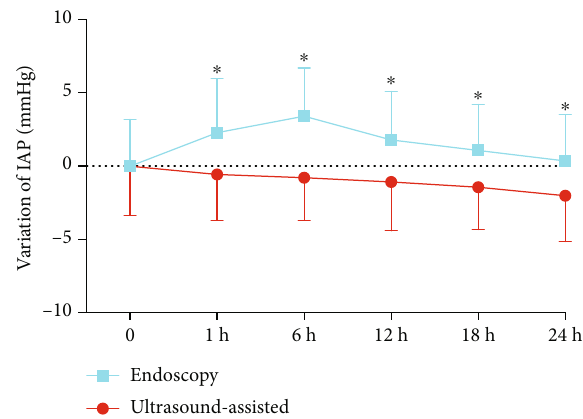
Figure 2: Change of intra-abdominal pressure in two groups after nasojejunal tube placement. IAP: intra-abdominal pressure ( ∗ P < 0 : 05